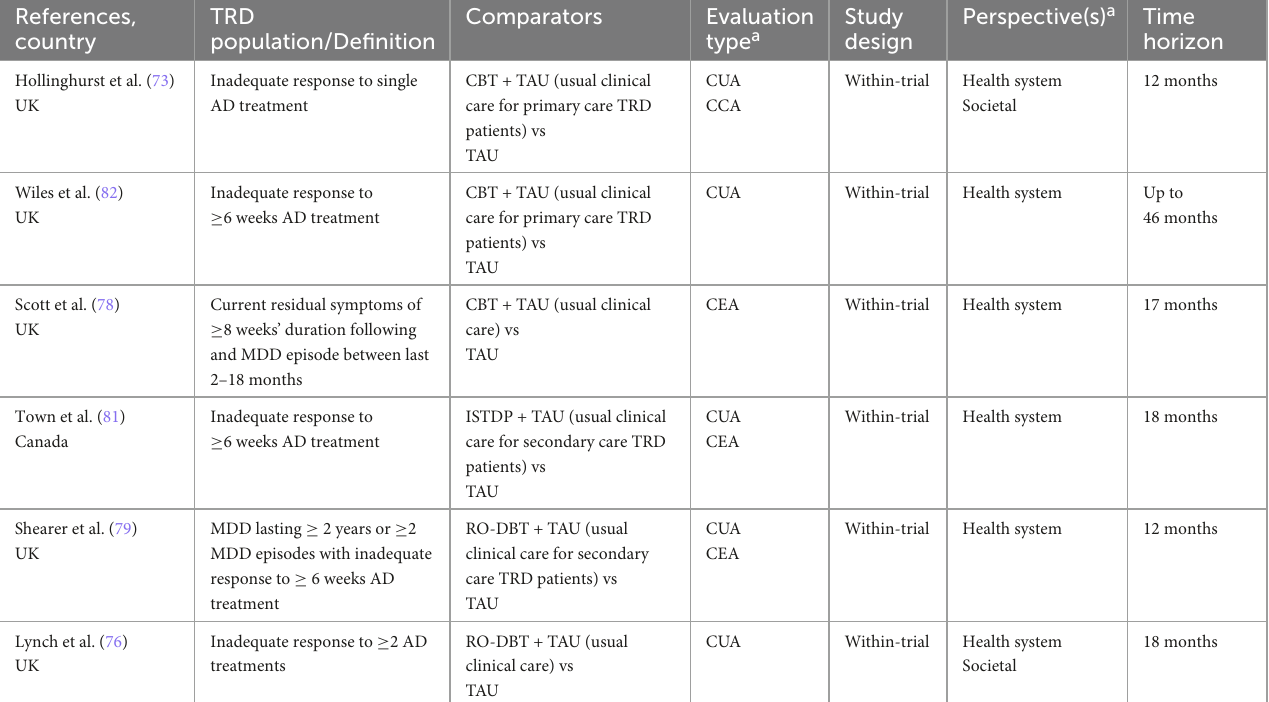
TABLE 2C Characteristics of economic evaluations of psychological